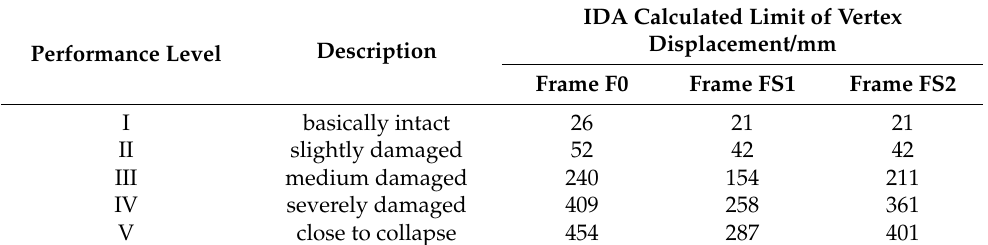
Table 2. Maximum interlayer displacement angle limit at each performance level (PL).